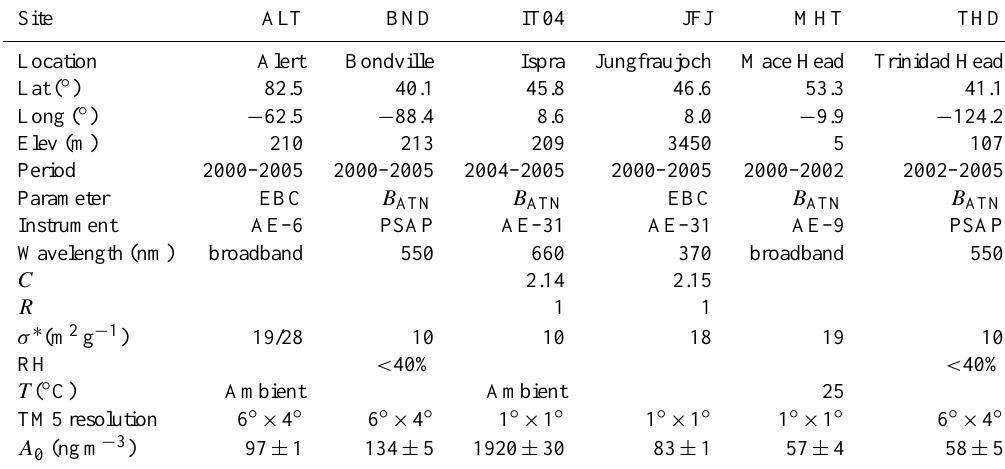
Table 1. Site description, model and experimental details.